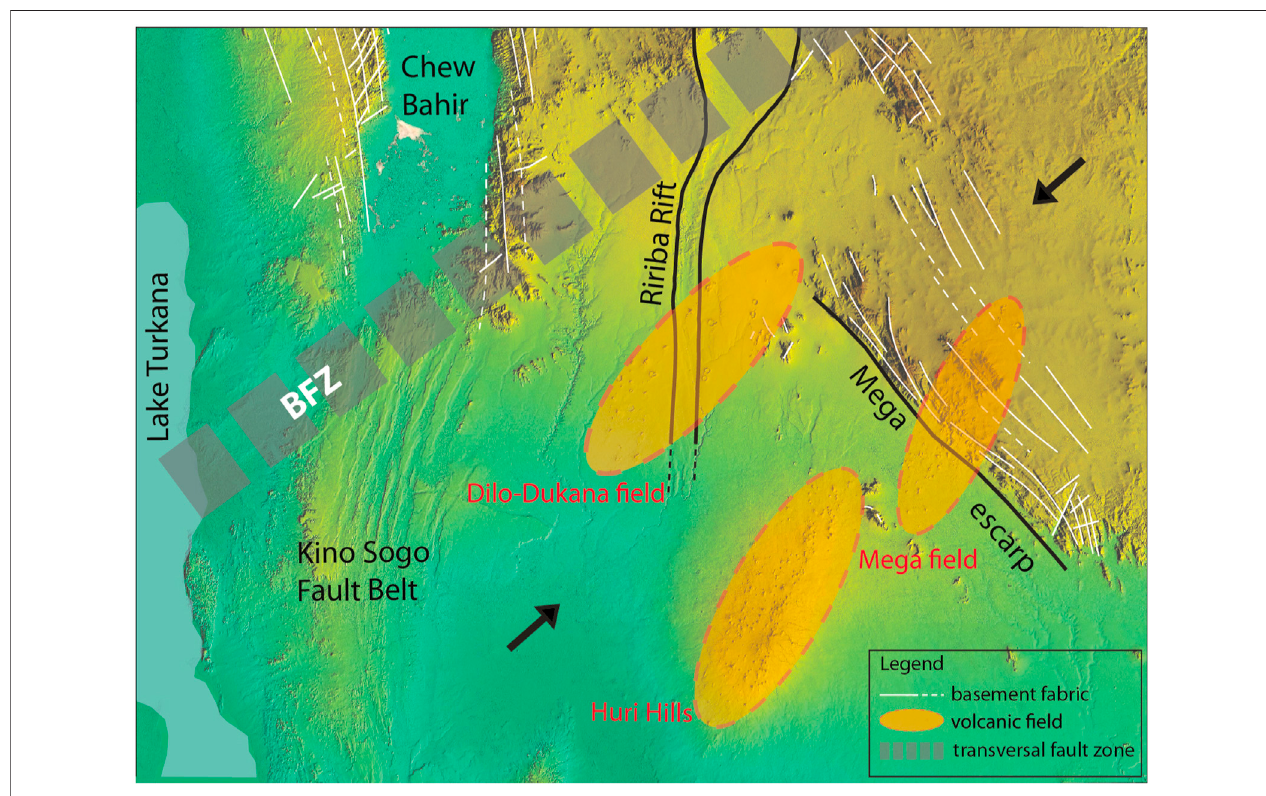
FIGURE 10 | Schematic relations between the distribution of the Quaternary volcanic fi elds of Dilo, Mega and Huri Hills (orange ellipses) and major inherited structures (dashed lines in the fi gure) such as the BFZ (Buluk Fault Zone), modi fi ed from Franceschini et al. (2020). Black arrows schematically indicate the main compressive stress resulting from buoyancy forces in the area related to variations in crustal thickness and topography. See text for details.